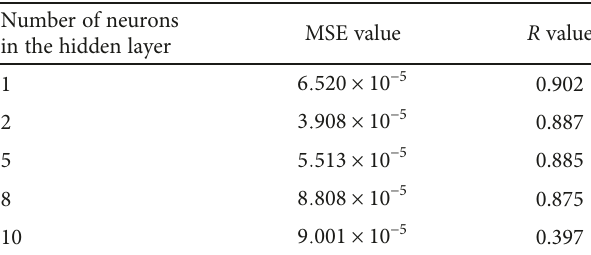
Table 8: Values of MSE and R depending on the number of neurons in the hidden layer in model ANN 3.